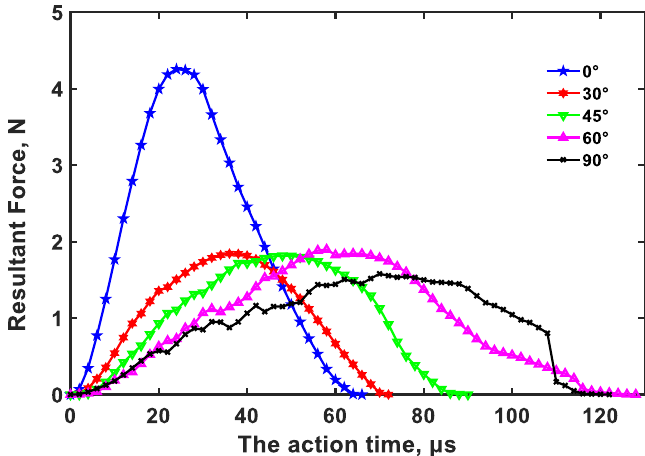
Figure 6. Simulation curves under different collision angles.